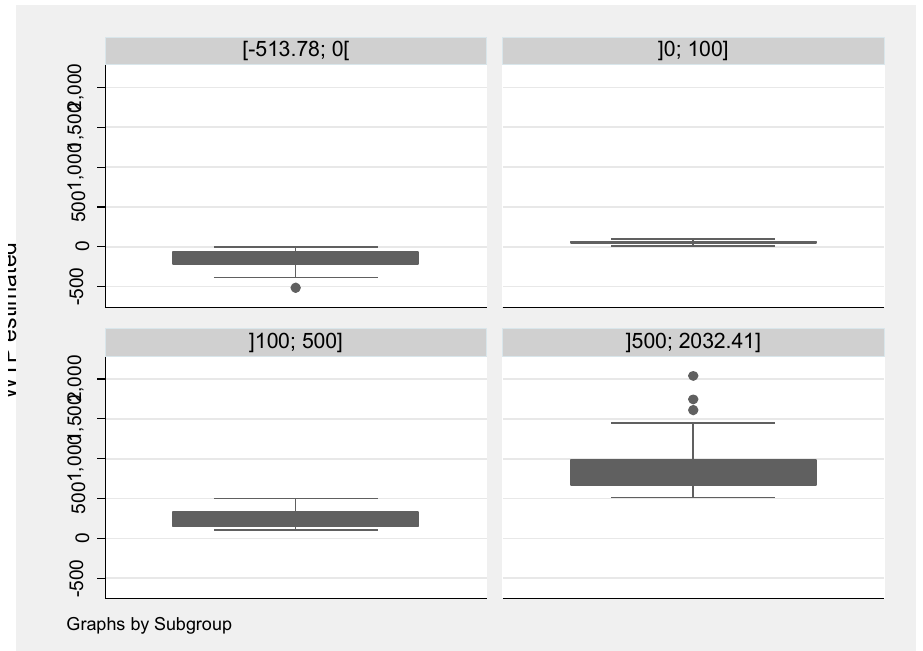
Figure 1. Distribution of WTP per kg of fly larvae according poultry farmers in